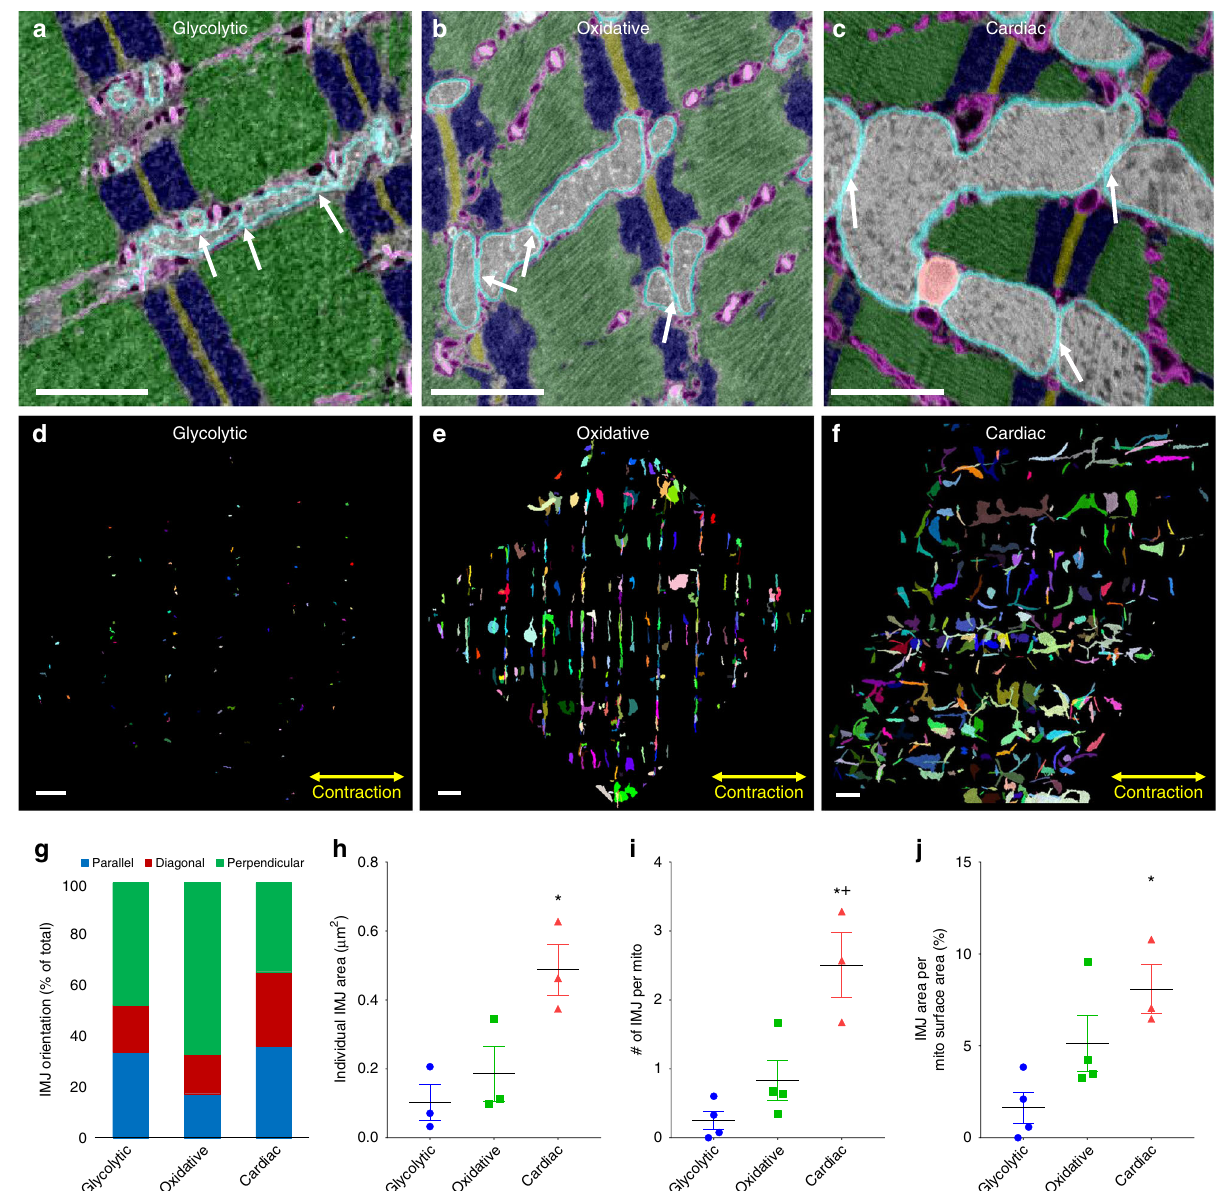
Fig. 3 Intermitochondrial junction morphology varies by muscle type. a Overlay of raw and segmented single image from glycolytic muscle SBF-SEM volume highlighting intermitochondrial junctions (IMJs, white arrows). Outer mitochondrial membrane – cyan, mitochondrial interior – gray, sarcoplasmic reticulum and t-tubules – magenta, z-disks – brown, I-bands – blue, A-bands – green. b Segmented and raw single image from oxidative muscle FIB-SEM volume highlighting IMJs. c Segmented and raw single image from cardiac muscle FIB-SEM volume highlighting IMJs. d – f Maximum projections of all glycolytic ( d ), oxidative ( e ), and cardiac ( f ) muscle IMJs. g Quanti fi cation of IMJ orientation. h Individual IMJ sizes. glycolytic, n = 170 IMJs, 3 datasets; oxidative, n = 952 IMJs, 3 datasets; cardiac, n = 2403 IMJs, 3 datasets. i Number of IMJs per mitochondria. glycolytic, n = 1336 mitochondria, 4 datasets; oxidative, n = 2623 mitochondria, 4 datasets; cardiac, n = 1890 mitochondria, 3 datasets. h IMJ Area per mitochondrial surface area. glycolytic, n = 1336 mitochondria, 4 datasets; oxidative, n = 2623 mitochondria, 4 datasets; cardiac, n = 1890 mitochondria, 3 datasets. Points are means for each dataset. Bars represent muscle type overall mean ± SE. *Signi fi cantly different from glycolytic, + signi fi cantly different from oxidative. Signi fi cance determined as p < 0.05 from one way ANOVA with Tukey ’ s HSD (variances not different) or Dunn ’ s multiple comparisons (variances different) post hoc tests. Scale bars – 1 µ